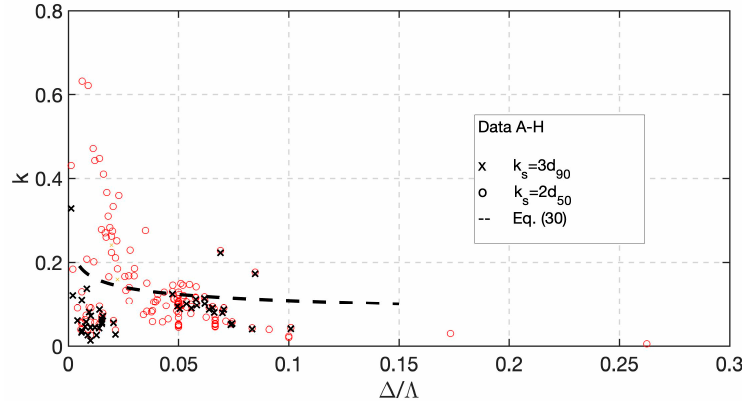
Figure 4. Empirical drag coefficient κ as a function of dune steepness δ = Δ / Λ . Comparison between results obtained by using different equivalent roughness k s (Data A–G see Table 1).